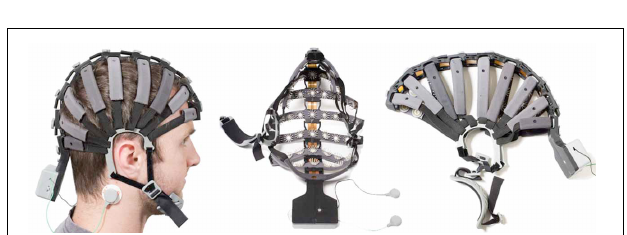
FIGURE 3 | Left: Subject wearing the headset. Reference electrodes are allocated on the side of the neck. Middle: View from the interior part of the headset with the structure that holds the electrodes. Right: Headset maintains its shape when not utilized. Picture, courtesy of Cognionics (Cognionics, Inc., San Diego, CA